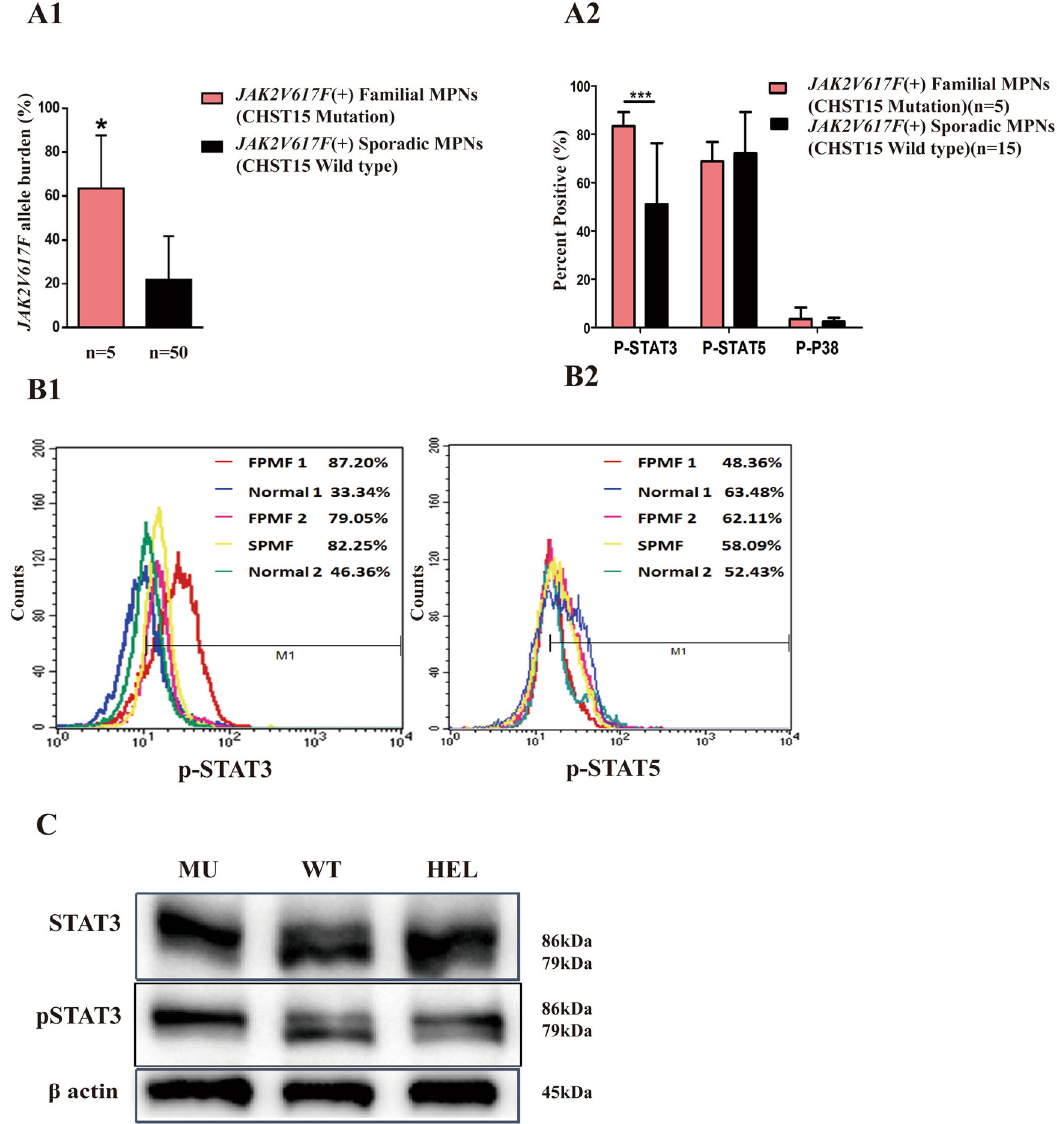
Fig. 3 Effects of CHST15 mutation on JAK2V617F allele burdens and proteins expression of p - stat3 , p - stat5 and p-p38 on PBMNCs from familial MPNs ( n = 5), sporadic MPNs ( n = 50). A1 Histograms show signi fi cantly increased JAK2V617F allele burdens in familial MPNs with CHST15 mutation ( p = 0.016). A2 Histograms indicate upregulated p - stat3 expression in familial MPNs corresponding to sporadic MPNs ( n = 15) ( p < 0.001); but no statistic difference is found for p - state5 and p-p38 between familial MPNs and sporadic MPNs. B1 / B2 : A representative FCM fi gures for p-stat3 and p-stat5 assays. Data are presented as mean ± s.e.m. *** p < 0.001; * p < 0.05, Student ’ s t test. C Western blot results show that cells harbouring CHET15 mutation present upregulated expression of p-stat3